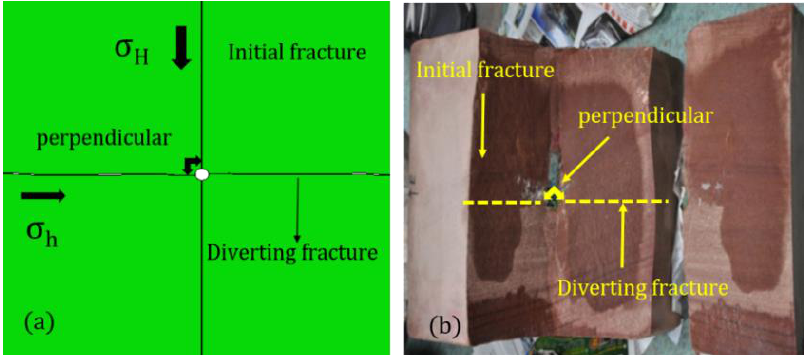
Figure 6. Comparison result between numerical model and experiment: ( a ) numerical result based on extended finite element method (XFEM); and ( b ) true tri-axial experiment result [ 40 ].